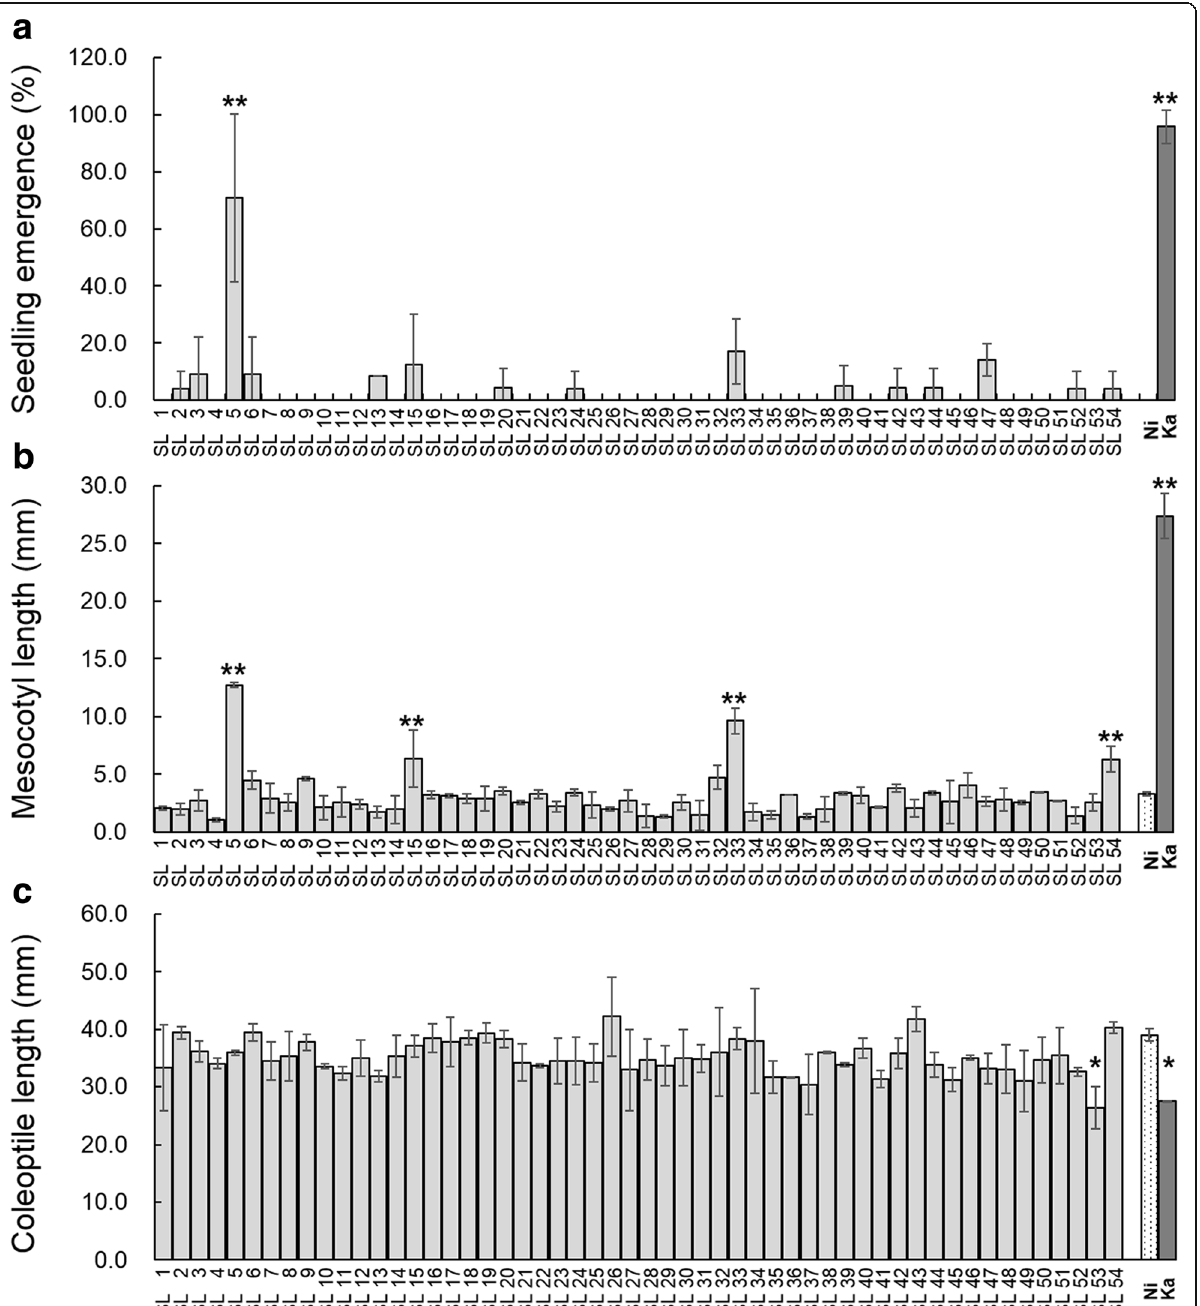
Fig. 4 Seedling emergence percentage at 6 days after sowing ( a ), mesocotyl ( b ) and coleoptile length ( c ) of 54 CSSLs (SL); 12 seeds of 54 CSSLs, Nipponbare and Kasalath were sown at 5 cm soil depth and incubated and the numbers of emerged seedling from the soil surface were counted. At 14 days after sowing, the length were measured. Each column represents emergence percentage or mean of length ± SE * P < 0.05 and ** P < 0.01 versus Nipponbare (Dunnett ’ s multiple comparison test, two